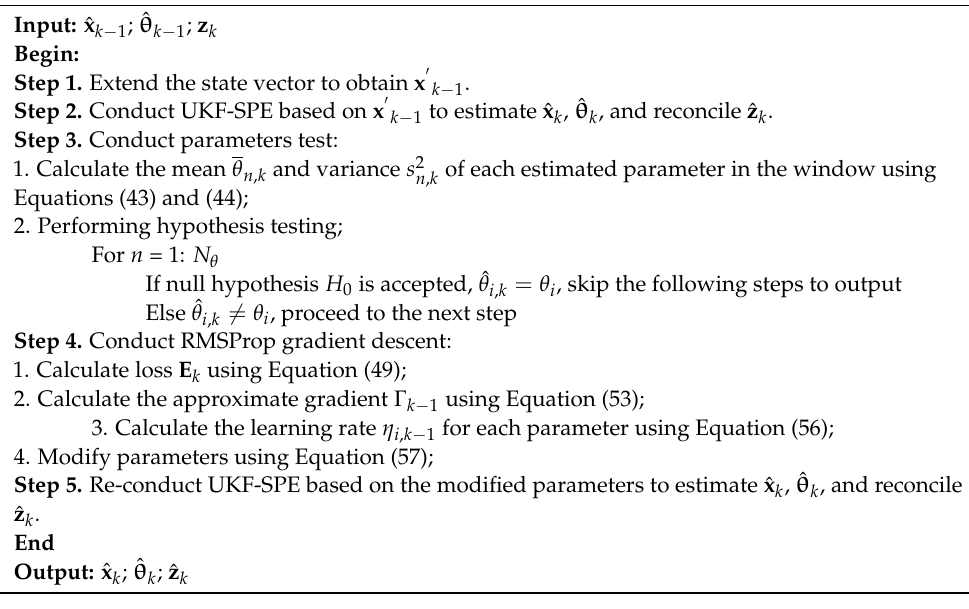
Algorithm 1: UKF-based robust